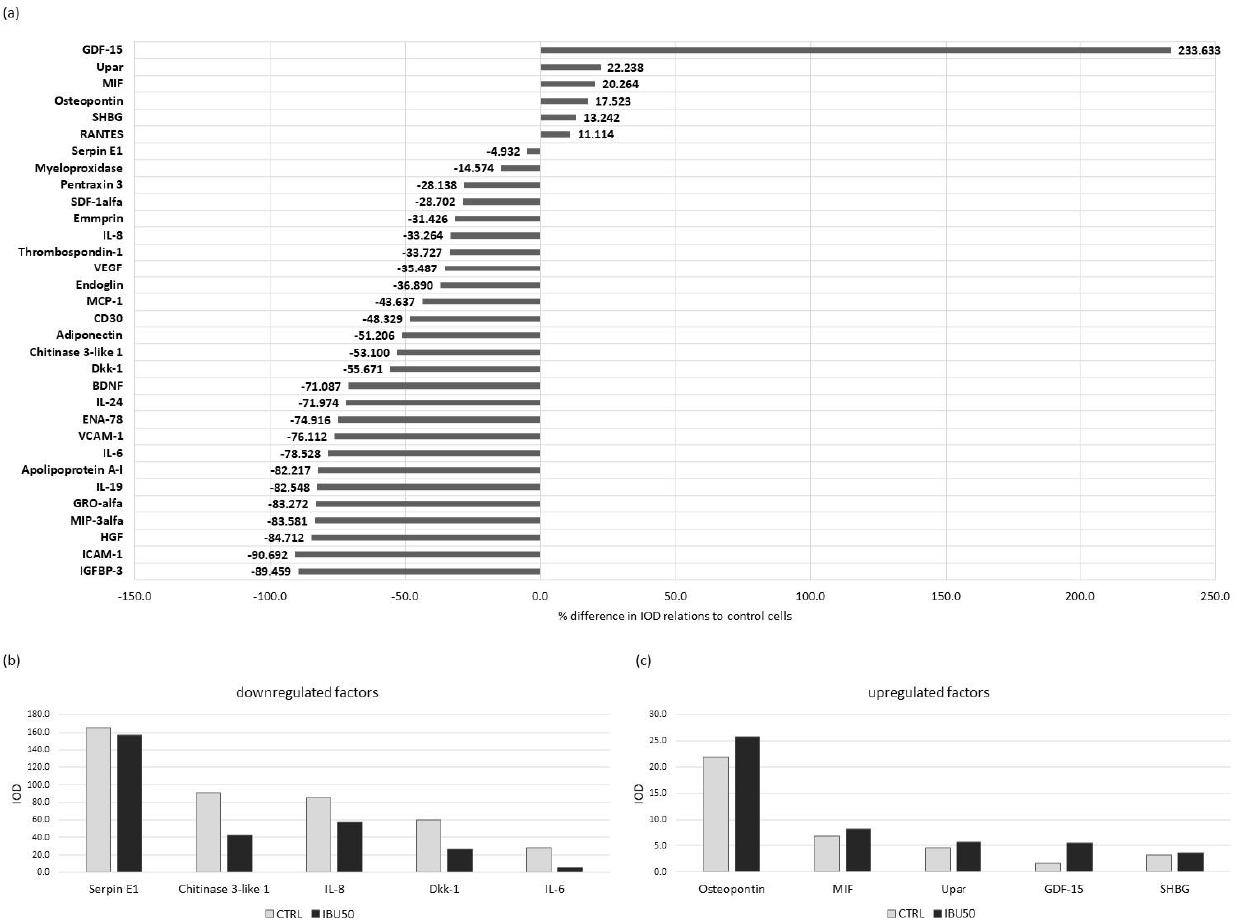
Figure 5. Proteome Profiler analysis of cytokines and chemokines secreted by hBM-MSCs. Semi- quantitative evaluation of secretion levels of over 100 human cytokines produced by BM-MSCs cultured in control medium (CTRL) or in medium with 50 µg/mL of ibuprofen for 72 h. For this analysis, supernatants collected from 6 BM-MSCs donors were pooled. ( a ) Cytokines levels changed after ibuprofen treatment in comparison to the control group. Data are presented as a percentage of control MSCs secretion (100%). ( b ) Factors decreased after ibuprofen treatment which was most abundantly secreted by untreated cells (factors which gave signal of highest density). ( c ) Factors which increased after ibuprofen treatment. Bars represent IOD (integrated optical density) of antibodies–dots measured by chemiluminescent